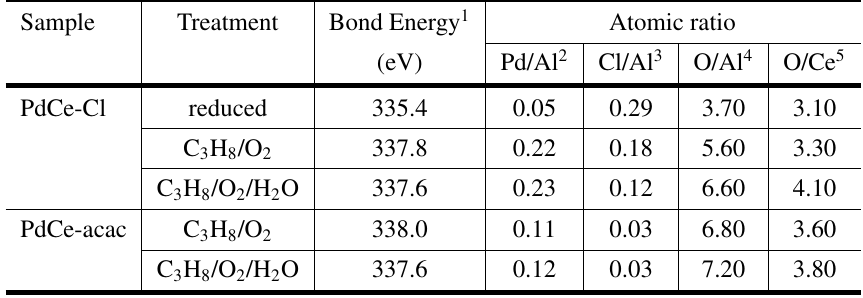
Bond Energy for Pd 3d 5/2 and atomic ratios by XPS for Pd/CeO 2 /Al 2 O 3